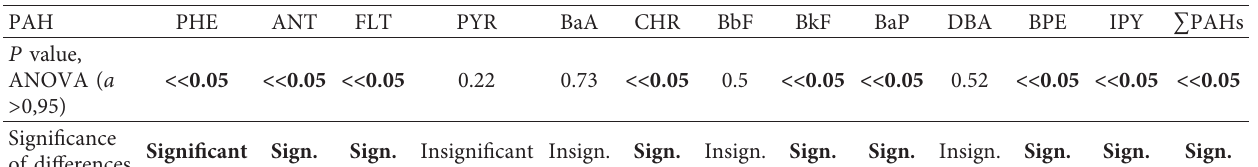
Table 1: Statistical data